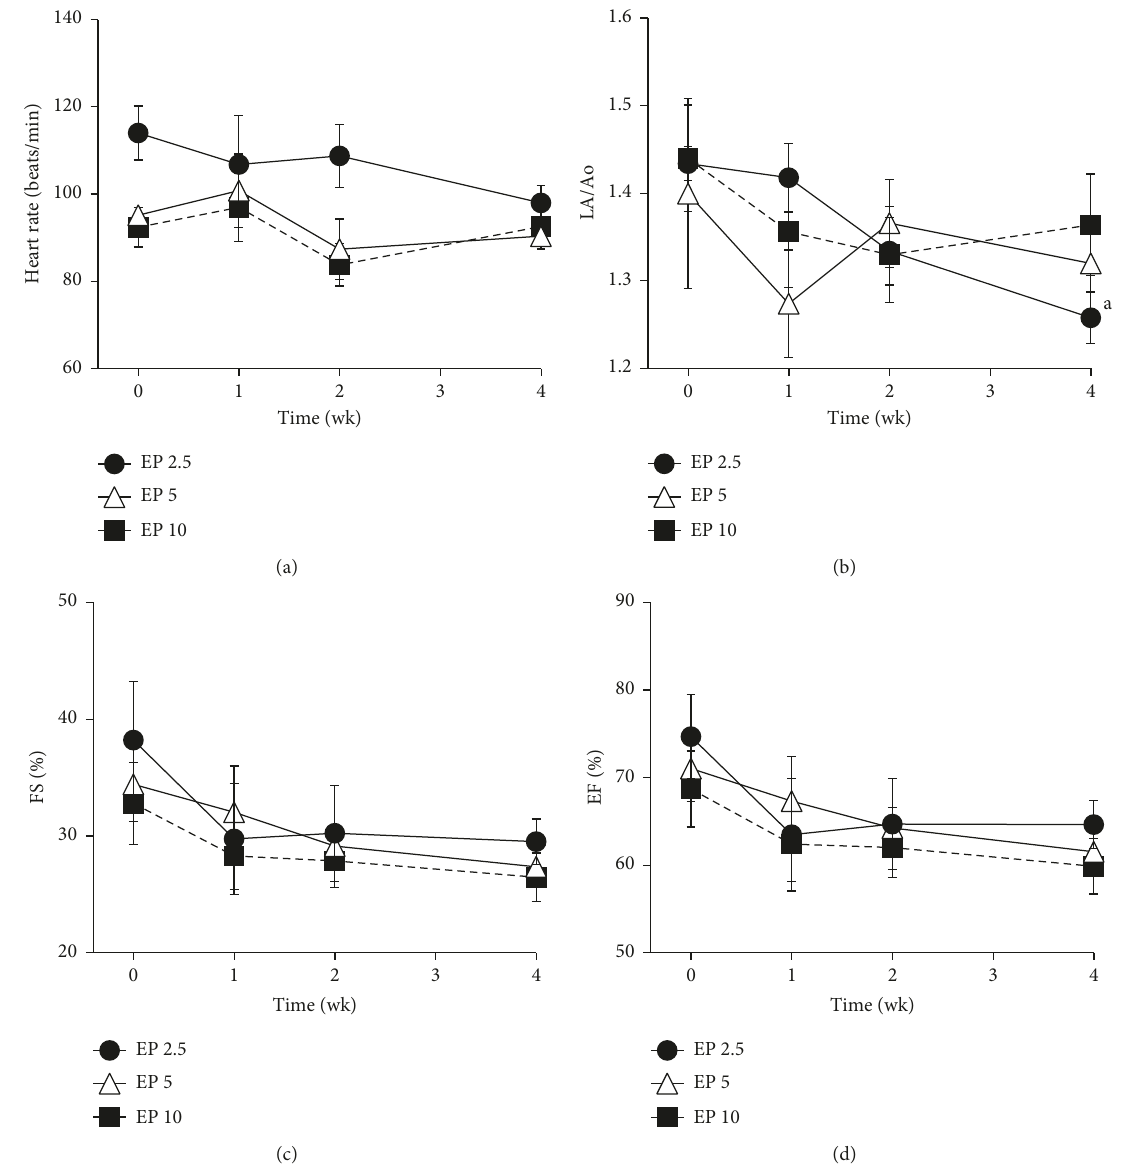
Figure 1: Heart rate (a), left atrium/aorta (LA/Ao) ratio (b), left ventricular fractional shortening (FS) (c), and left ventricular ejection fraction (EF) (d) after eplerenone (EP) administration in dogs. EP 2.5, 5, and 10: eplerenone 2.5, 5, and 10mg/kg, respectively. Each time point and vertical bar represent the mean and standard error ( n � 5). The lowercase letters indicate a significant difference from baseline (0) value (a— P < 0 .